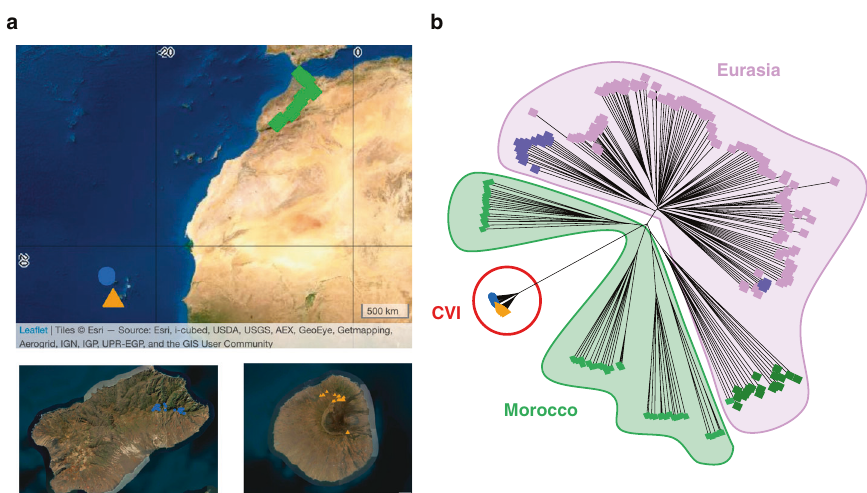
Fig. 1 Population structure of Cape Verde Arabidopsis . a Sample locations of sequenced lines from Morocco (green, n = 64) and the Cape Verde Islands, Santo Antão (blue, n = 189) and Fogo (orange, n = 146). The base map used derives from the World Imagery Map 117 and was accessed through the R package lea fl et 118 . Values on the x -axis and y -axis represent, respectively, longitude and latitude. b Neighbour-joining tree showing relationship of CVI ( n = 336, in blue and orange) to worldwide samples. Morocco: n = 64, in green; Eurasia: n = 180, including 20 samples, each from 9 representative clusters 26 . Divergent Iberian lines, or relicts, are shown in dark green, other Iberian lines (non-relicts) are shown in purple, and all other Eurasian lines in magenta. Source data are provided as a Source Data fi le.